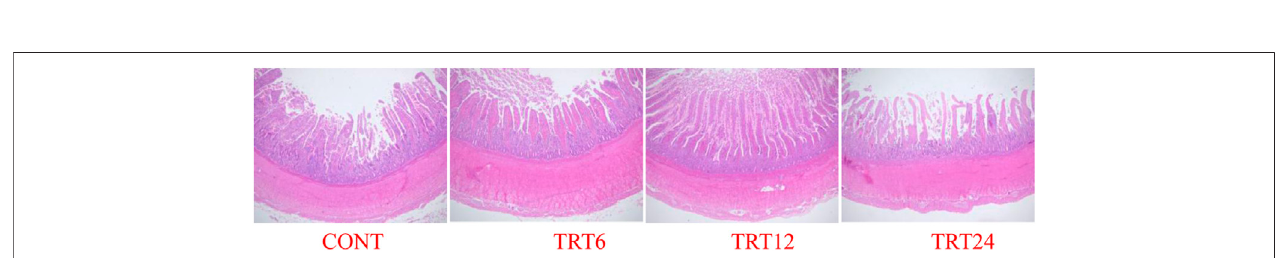
Frontiers in Physiology |